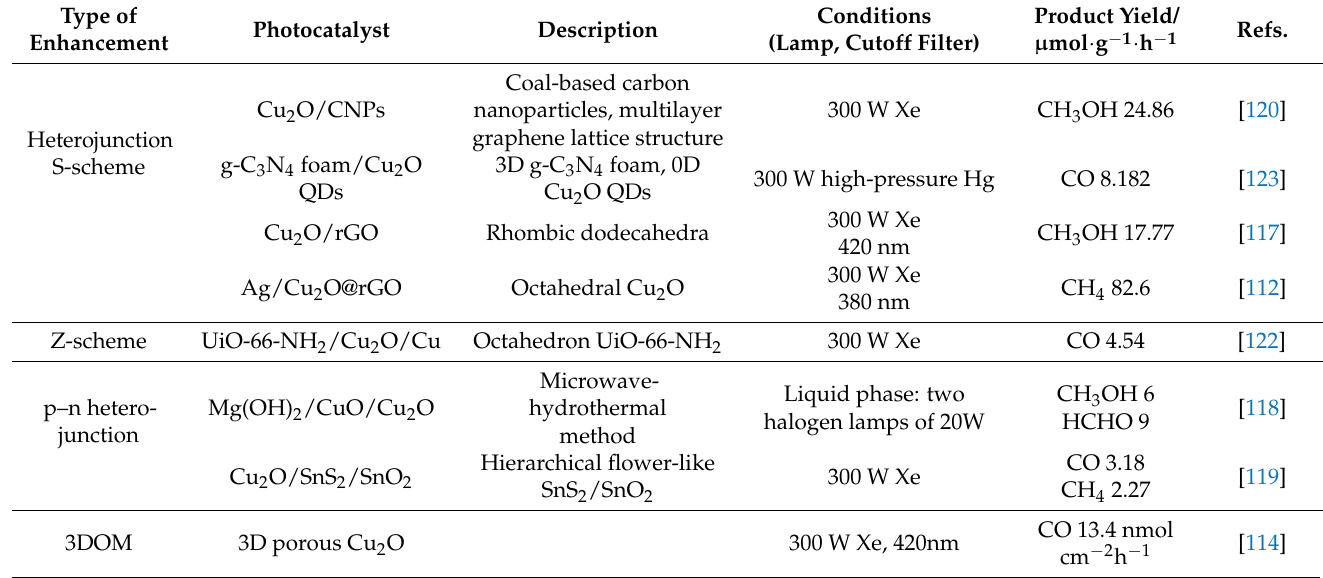
Table 4. Summary of the recent results on the photoreduction of CO 2 by Cu 2 O-based